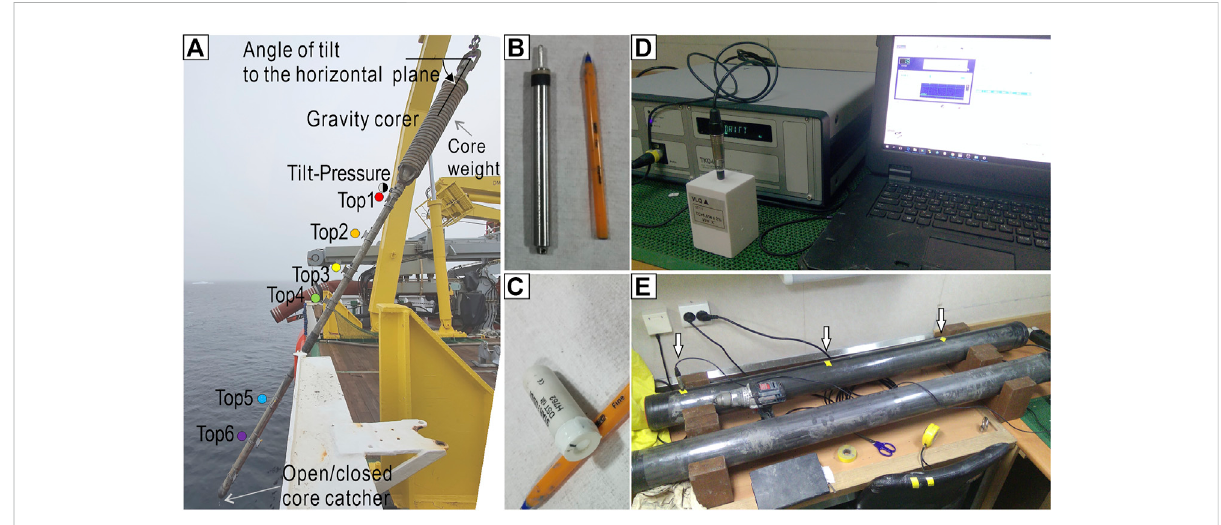
FIGURE 2 Theheatprobecomprisesthegravitycorerasaframe,temperaturesensors(AntaresMiniaturizedTemperatureDataLogger(MTL);Top1to 6in (A) , and tilt-pressure sensor (Star-Oddi DST Tilt; Tilt Pressure on A), which was operated in the main back deck of IBRV Araon . The winch cable with the heat probe is connected to the top of the corer. The length of the corer is 8.5 m. The tilt sensor records an angle of the corer regarding a horizontal plane such that a tilt reading of 90 ° implies that the corer stands perpendicular to the horizontal plane. The MTL and DST Tilt are shownin (B) and (C) ,respectively,withaball-penforscale.Thethermalconductivitymeter(TeKaTK04)withaneedleprobe(TeKaVLQ) (D) isusedto measure the thermal conductivity of the retrieved sediment core at intervals of 20 – 40 cm (white arrows in (E) ). The laboratory temperature is 20 °